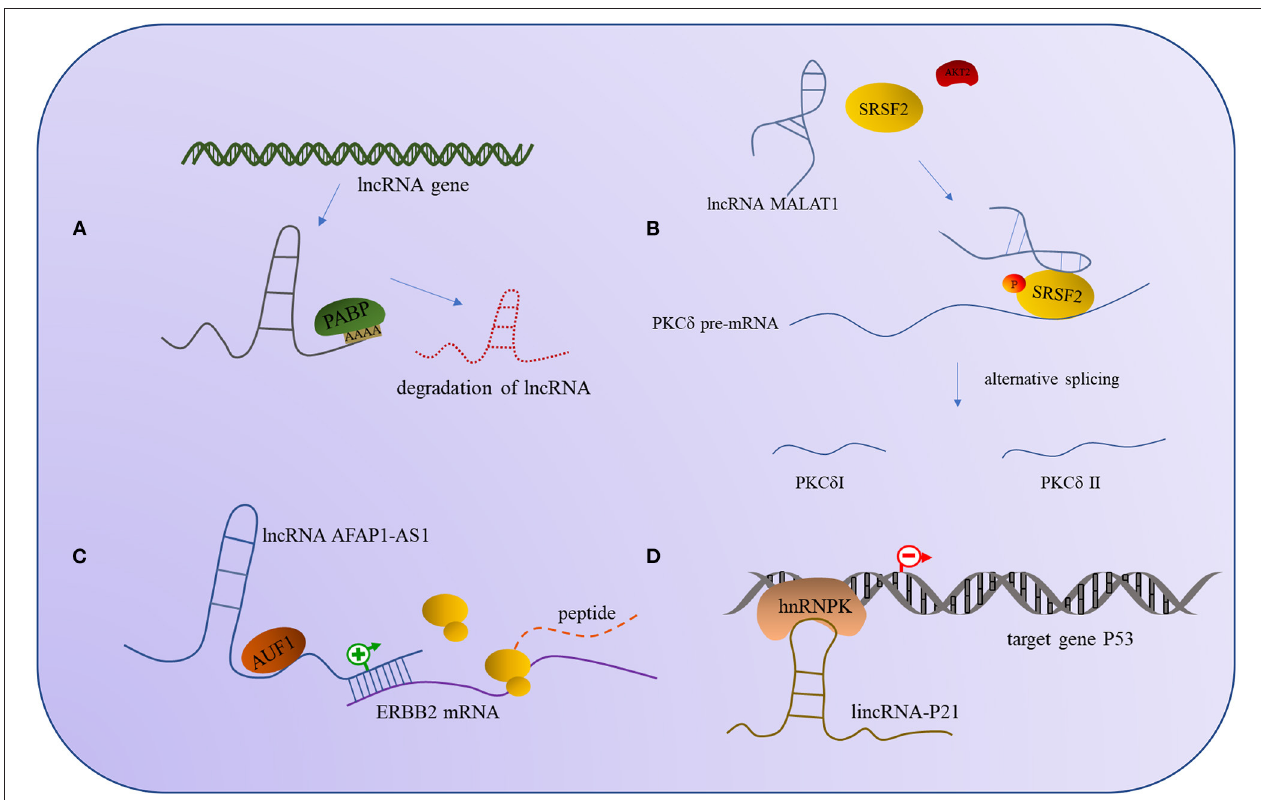
FIGURE 2 | The interaction models between lncRNA and RNA-binding protein. (A) PABP interacts with lncRNA induces the degradation of lncRNA. (B) The interaction of lncRNA AFAP1-AS1 and RBP AUF1 can promote the expression of ERBB2 mRNA. (C) The combination of lncRNA MALAT1 and SRSF2 can promote the phosphorylation of SRSF2 by AKT2 to alternative splicing PKC δ . (D) The interaction of hnRNPK and lincRNA-P21 can repress the expression of the target gene P53.